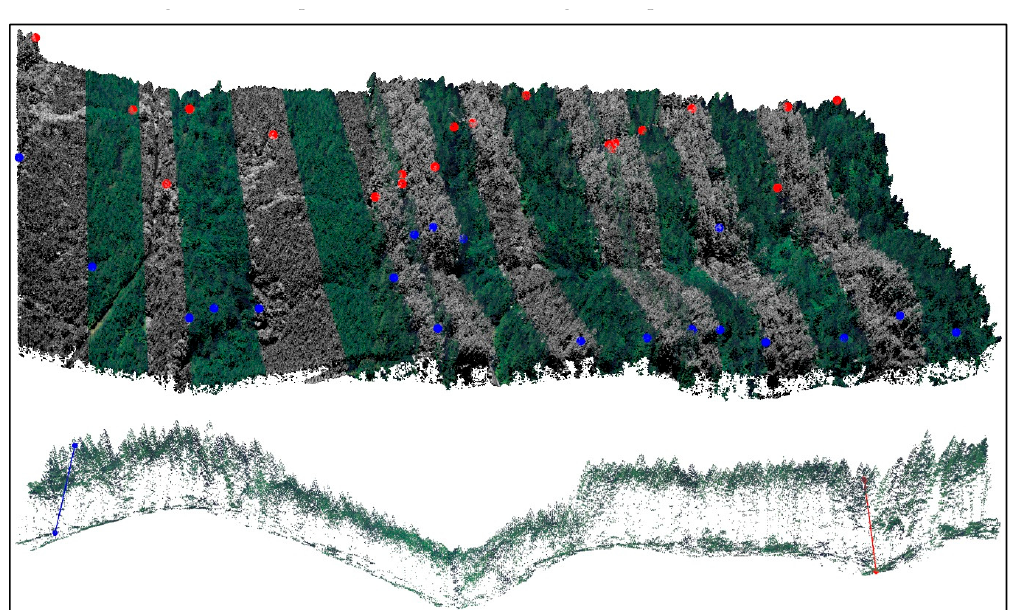
Figure 4. ( Top ) Perspective view of an ALS scan swath, showing return membership to 1s time intervals (blocks) colored by alternating intensity (gray-scale) and red-green-blue (RGB) values. Superimposed pairs of red and blue dots, one per time block, show first returns of pulses identified as optimal for determining the platform’s position. The aircraft was moving from right to left. Owing to variability in the speed and attitude of the airborne platform, block width varies. ( Bottom ) Profile of returns in a time block displayed perpendicular to the airborne platform trajectory, the calculated pair of optimal pulses, and their rays as colored lines. The width of the scan swath is approximately 250 m in both panels.